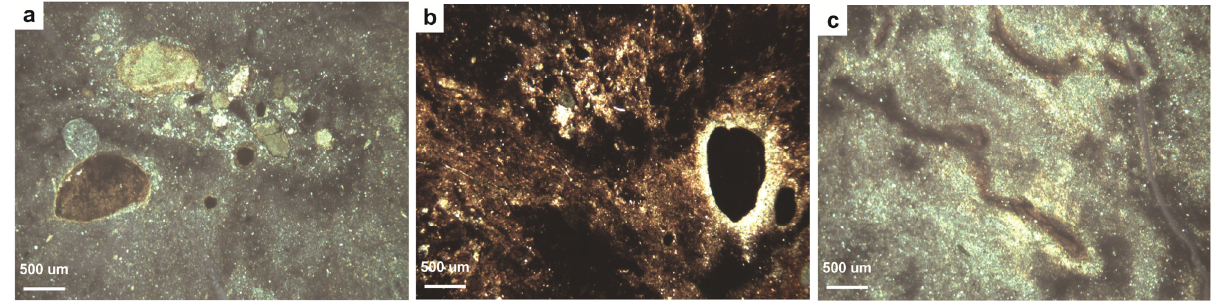
Figure 7. Microfabrics from Type B paleosols: ( a ) An agglomeroplasmic soil microfabric; ( b ) An insepic plasmic microfabric with local gleization around an iron nodule; ( c ) Vertically-oriented rhizohaloes and a mosepic plasmic